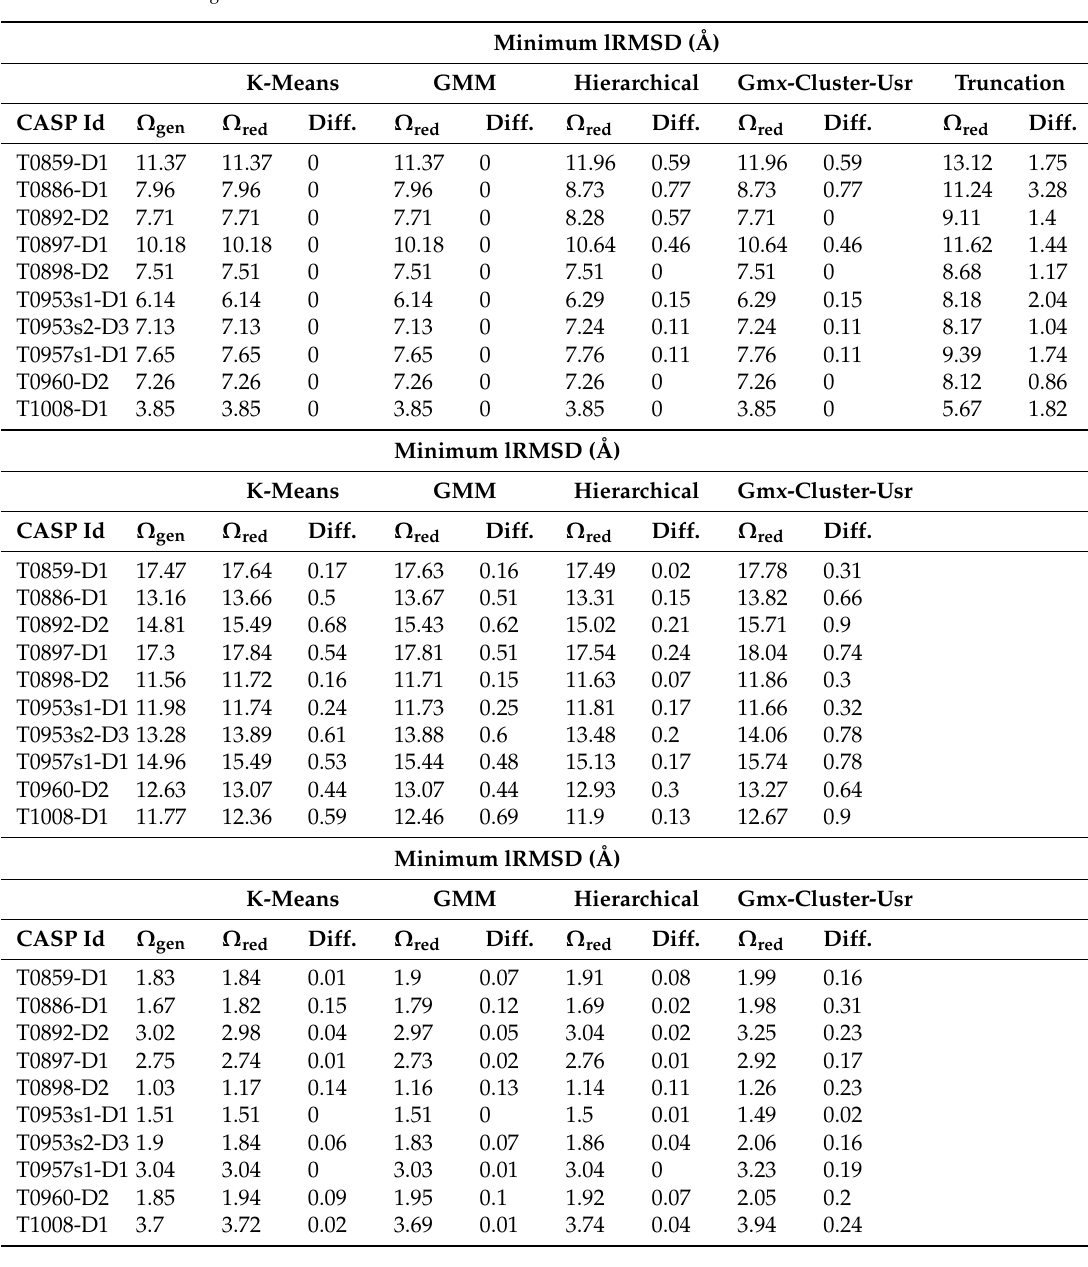
Table 4. Comparison of minimum, average, and standard deviation of distribution of lRMSDs (to the known native structure) of structures in the Ω gen and Ω red ensembles of each target in the CASP dataset. Comparison of minimum lRMSDs includes the ensemble reduced via truncation selection. Differences between the minimum, average, and standard deviation obtained over Ω red from those obtained over Ω gen are also